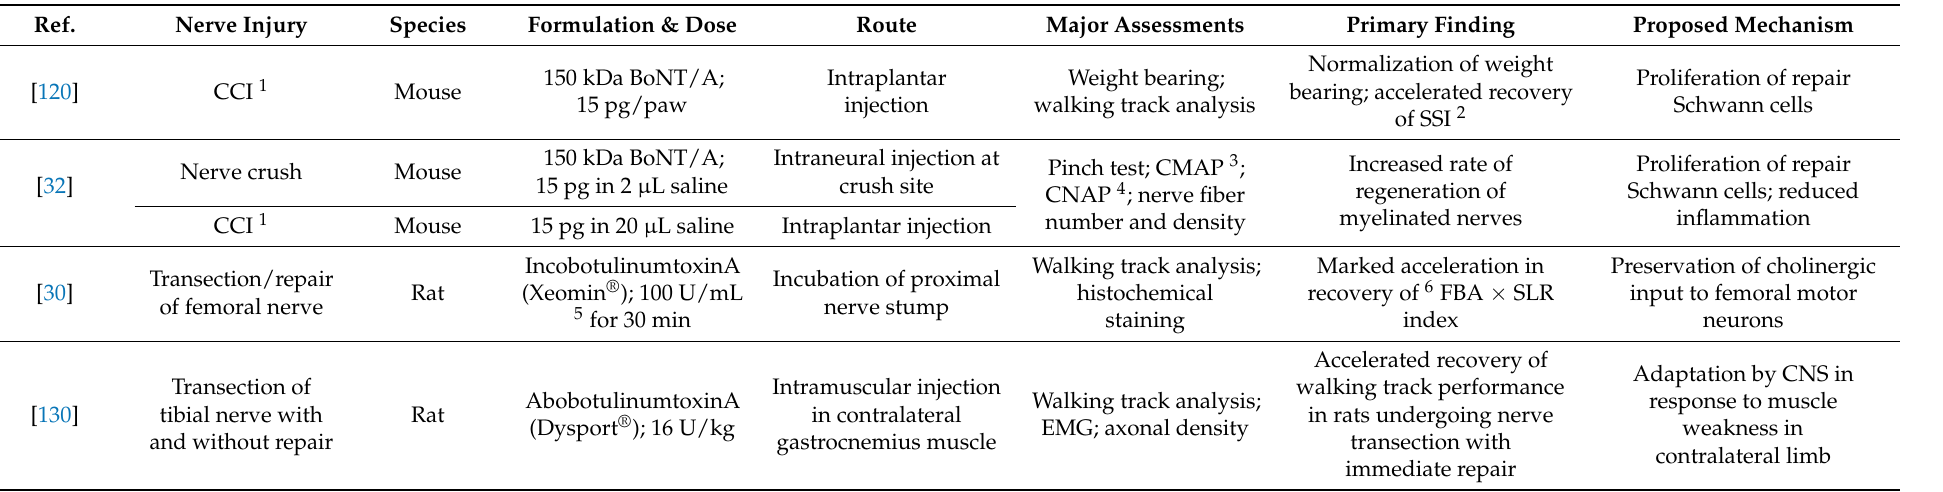
Table 1. Regenerative Actions of BoNT/A in Rodent Models.